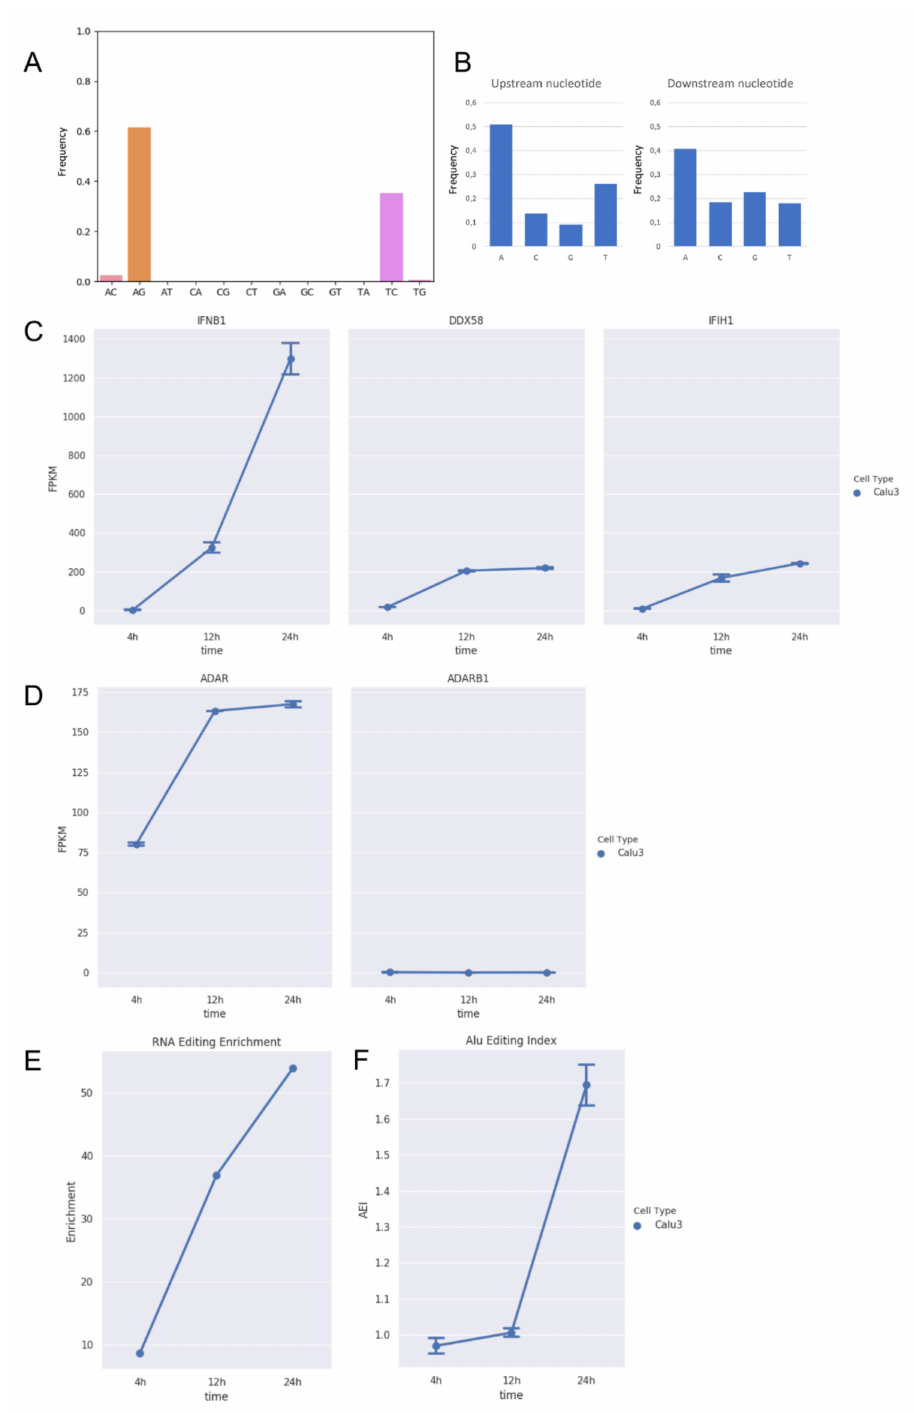
Figure 1. RNA editing and expression of key genes in total RNAseq data from Calu-3 infected cells at three time points post-infection (4 h, 12 h, and 24 h). ( A ) Distribution of hyper-edited reads identified in infected Calu-3 cells in which A-to-G and T-to-C events appear prominent. ( B ) Nucleotide context one nucleotide upstream and downstream the detected hyper-edited sites. ( C ) Gene expression of type-I interferon (IFNB1) and key sensor genes, DDX58 (RIG-I) and IFIH1 (MDA5), in infected Calu-3 cells. Here, we report only IFNB1 as main interferon gene modulated upon infection. As expected, DDX58 and IFIH1 increase their expression during the infection. Gene expression of type-I interferons, RIG-I and TLR receptors, and APOBECs are reported in the Supplementary Figure